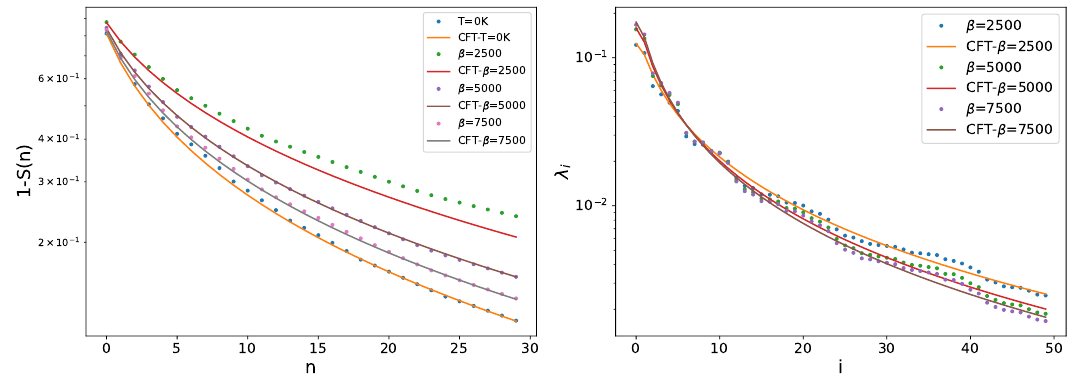
Figure 4 . Thermal correction to the entanglement spectrum for l/L = 1 / 3 . β/L is fixed at 0 . 25 , 0 . 5 and 0 . 75 . And the entanglement spectrum for the ground state ( T = 0 K ) is also presented in the left diagram for contrast. Left: 1 − S ( n ) , where S ( n ) = P i = n curve is calculated by (3.15) and